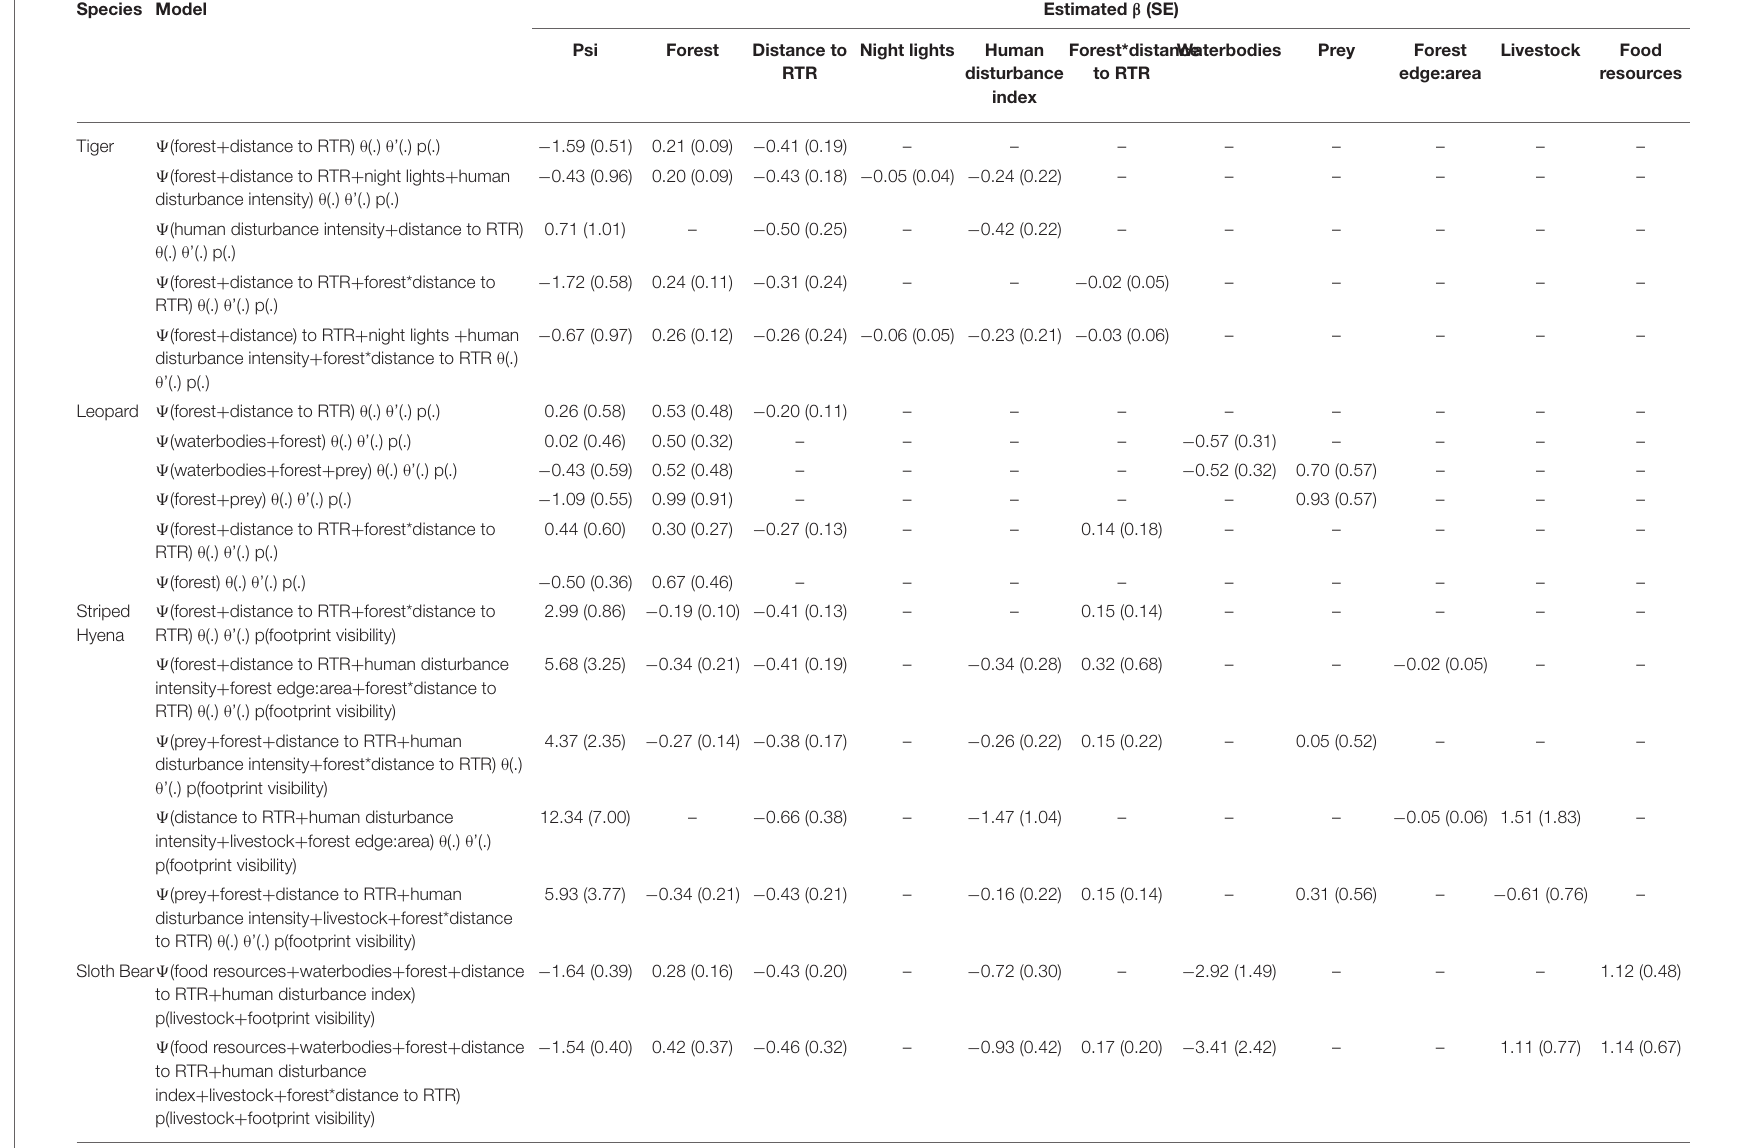
The estimates are only reported for models with a cumulative AICc weight > =